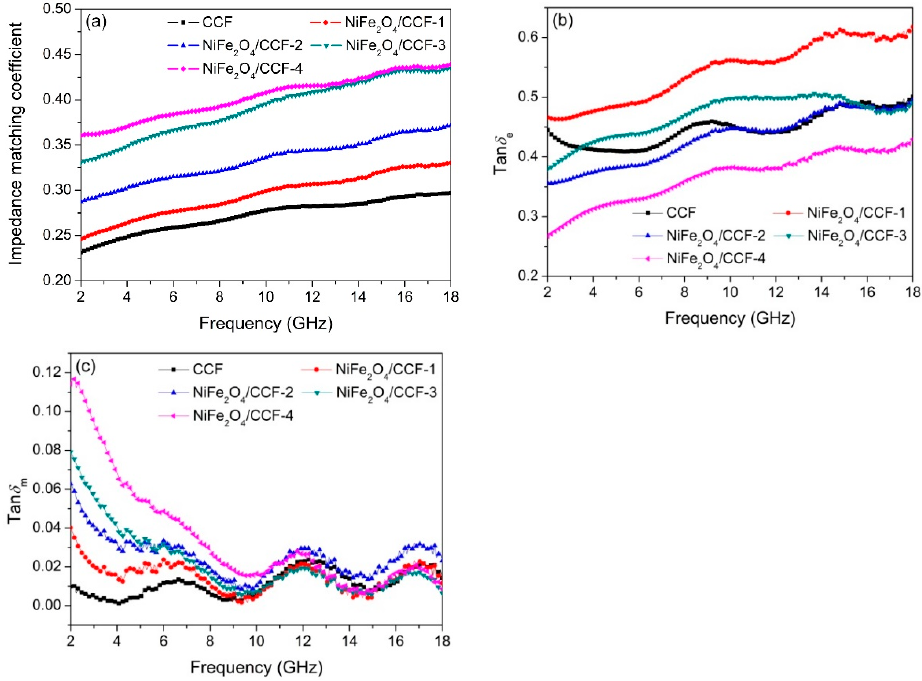
Figure 8. Frequency dependence of ( a ) impedance matching coefficient, ( b ) tan δ e , and ( c ) tan δ m of CCF, NiFe 2 O 4 /CCF-1, NiFe 2 O 4 /CCF-2, NiFe 2 O 4 /CCF-3, and NiFe 2 O 4 /CCF-4.